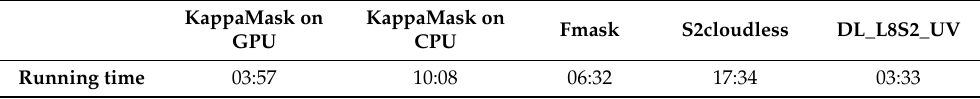
Table 11. Time comparison performed on one whole Sentinel-2 Level-1C product inference. Kap- paMask Level-1C with GPU and CPU, Fmask, S2cloudless and DL_L8S2_UV on generating 10 m resolution classification